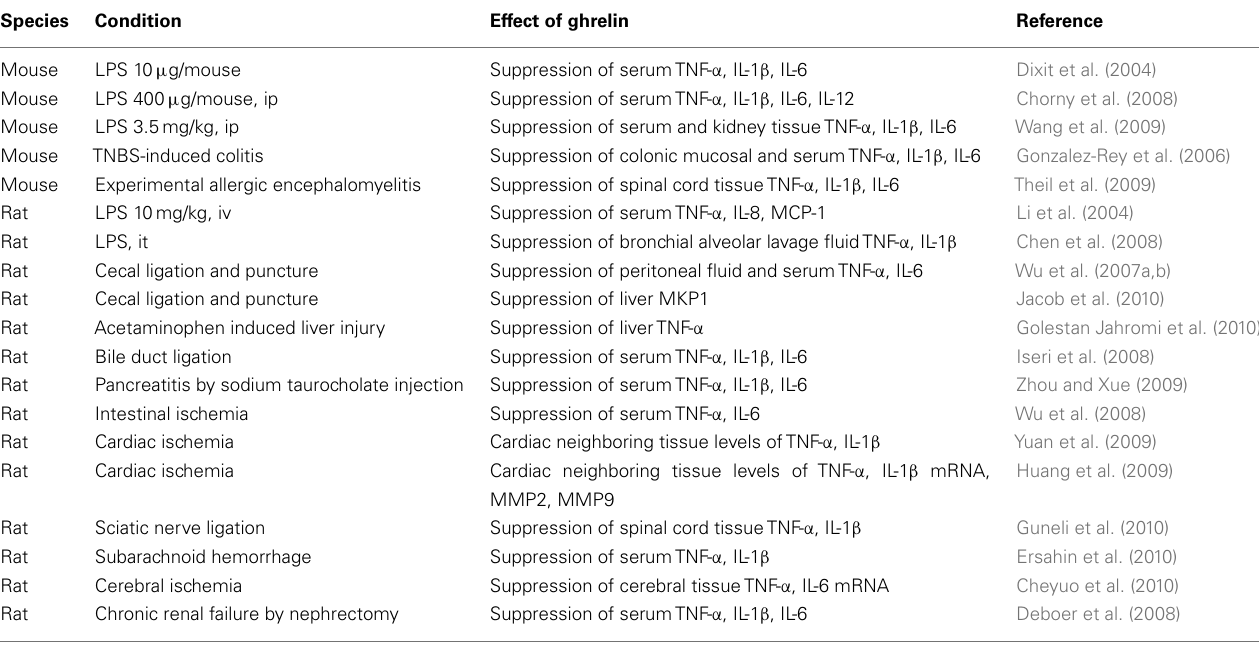
Table 1 | Effects of ghrelin treatment on cytokine levels in animal models of inflammation.